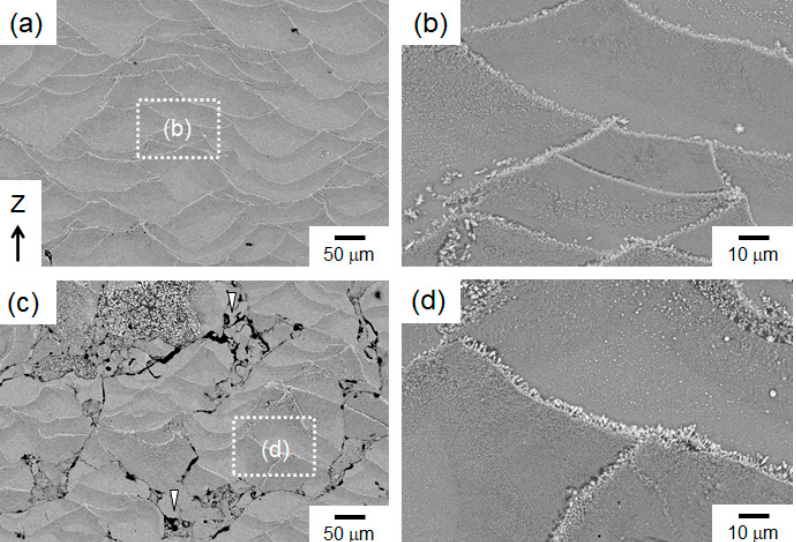
Figure 3. Backscattered electron images showing microstructures of laser powder bed fusion (L-PBF)-built Al–15%Fe alloy samples built under ( a , b ) 128 W–0.4 m·s –1 and ( c , d ) 77 W–0.8 m·s –1 .